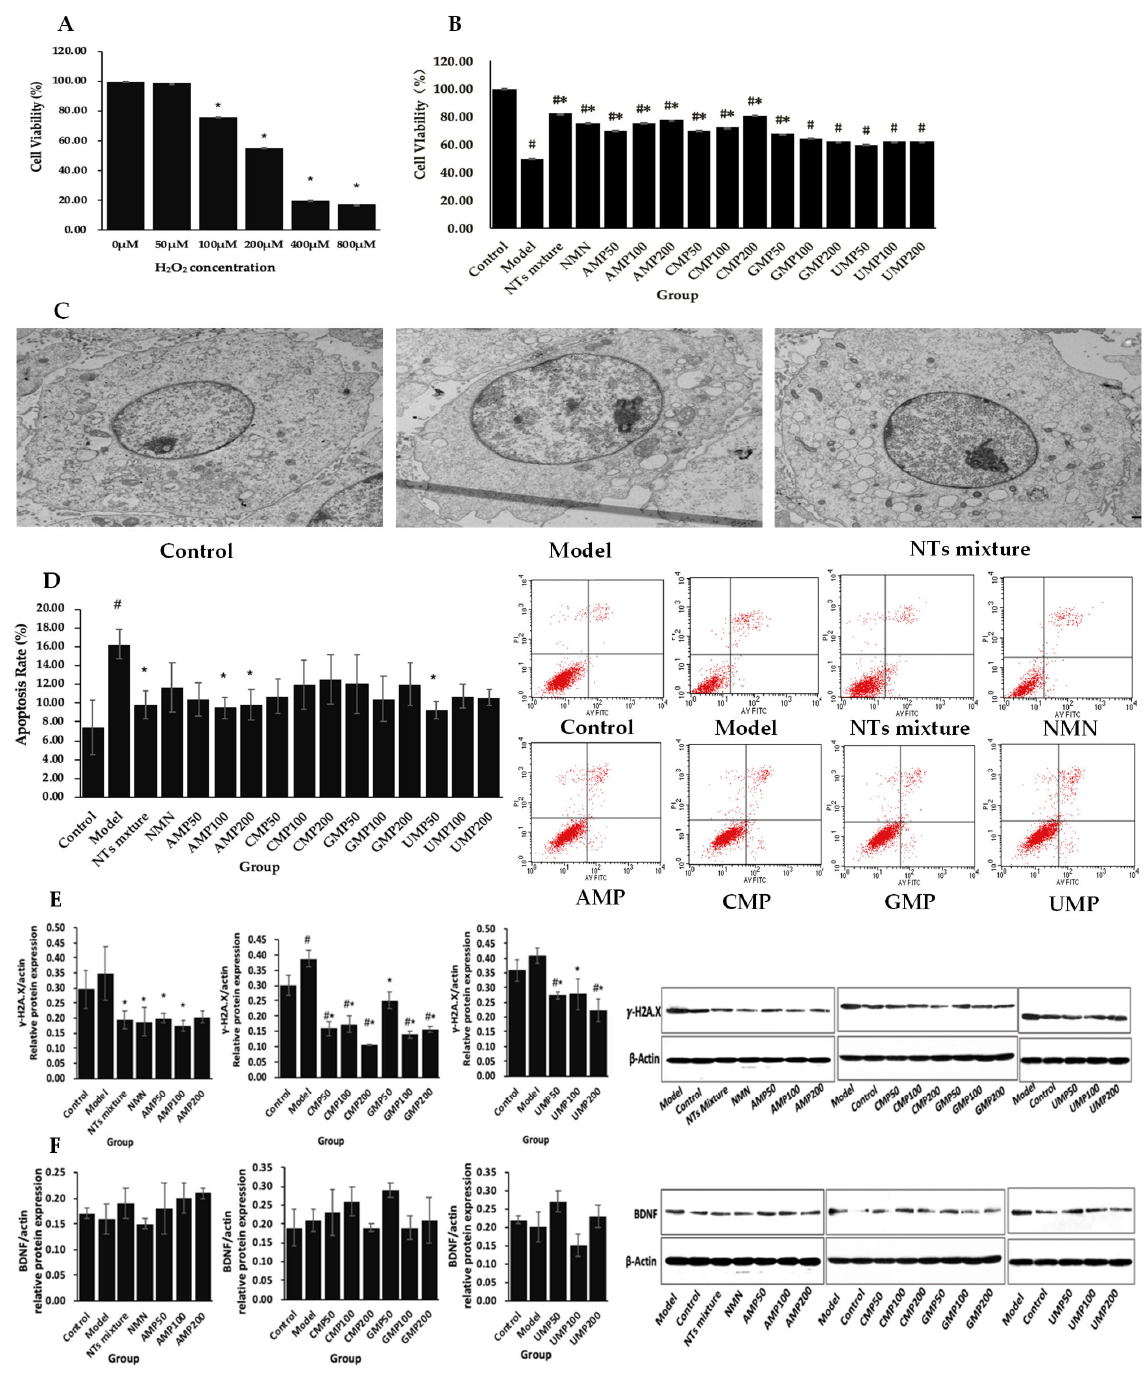
Figure 1. ( A ) The dose-dependent response of H 2 O 2 to PC-12 cells; ( B ) The cell viability evaluation of NTs using the CCK-8 assay; ( C ) The effect of NTs on the morphological changes of H 2 O 2 -treated PC-12 cells using transmission electron microscopy (3000×); ( D ) The effect of NTs on the cell apoptosis rate in H 2 O 2 -treated PC-12 cells; ( E ) The effect of NTs on the protein expression of γ -H2A.X in H 2 O 2 -treated PC-12 cells; ( F ) the effect of NTs on the protein expression of BDNF in H 2 O 2 -treated PC-12 cells ( n = 3 per group). # p < 0.05 versus control group, * p < 0.05 versus model group. H 2 O 2 -mediated neurotoxic effects changed the morphological structure of PC-12, and led to the display of an enlarged nucleus, chromatin pyknosis, irregular nuclear membranes, reduced mitochondrial numbers, and increased mitochondrial size. Compared with